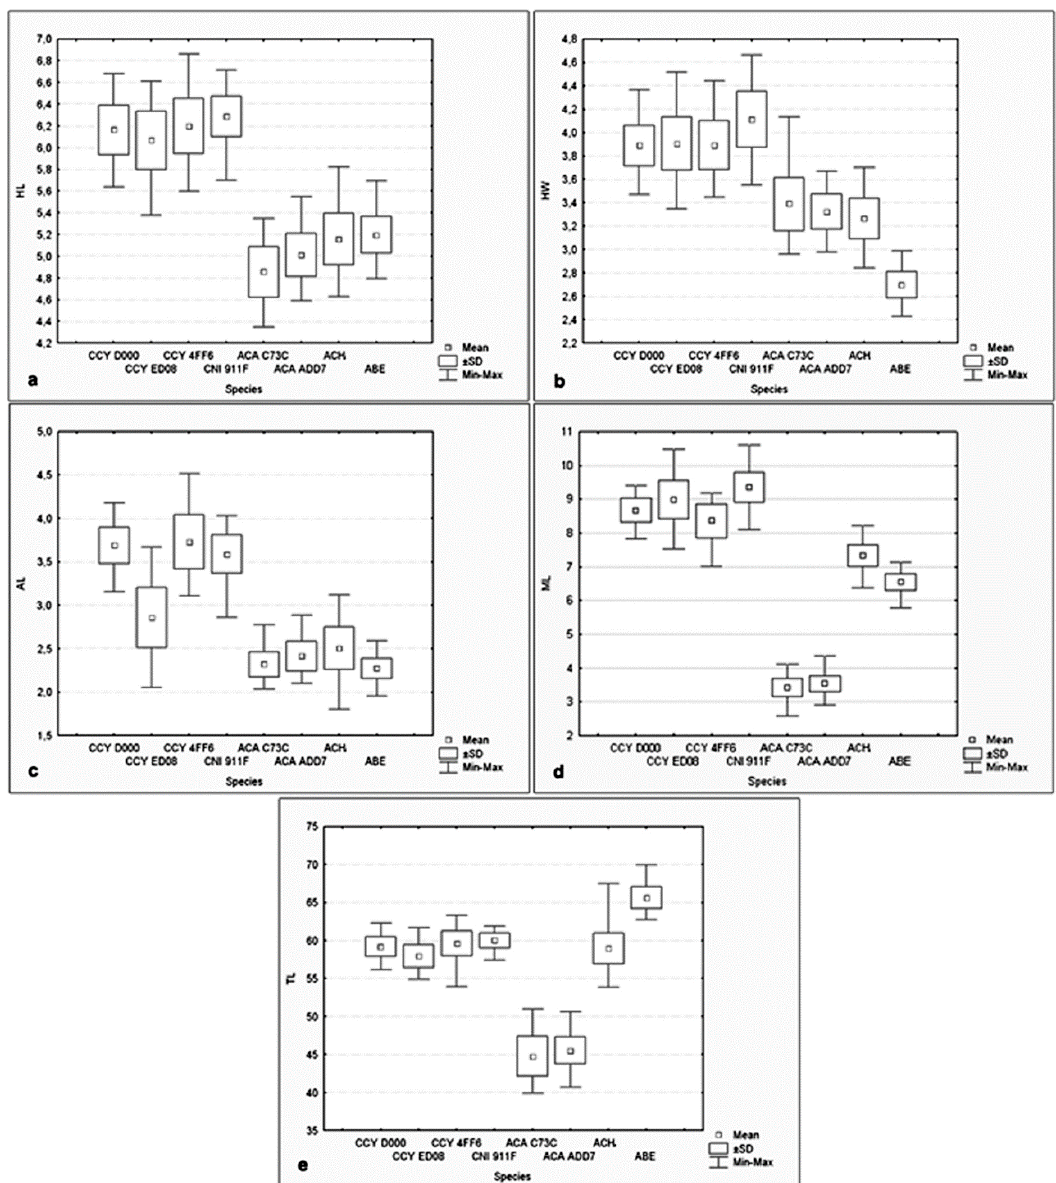
Figure 2. Box plots for the morphometric measurements made on spermatozoa of the studied neotropical primates. ( a ) Head Length (HL); ( b ) Head Width (HW); ( c ) Acrosome Length (AL); ( d ) Midpiece Length (ML); ( e ) Tail Length (TL). The square within the box indicates the mean, the boxes indicates the standard deviation interval (±SD) and the and the ends of the vertical line indicate the maximum and minimum values. Cebus cay (CCY, = Sapajus cay ); Cebus nigritus (CNI, = Sapajus nigritus ); Ateles belzebuth (ABE); Ateles chamek (ACH); Alouatta caraya (ACA).